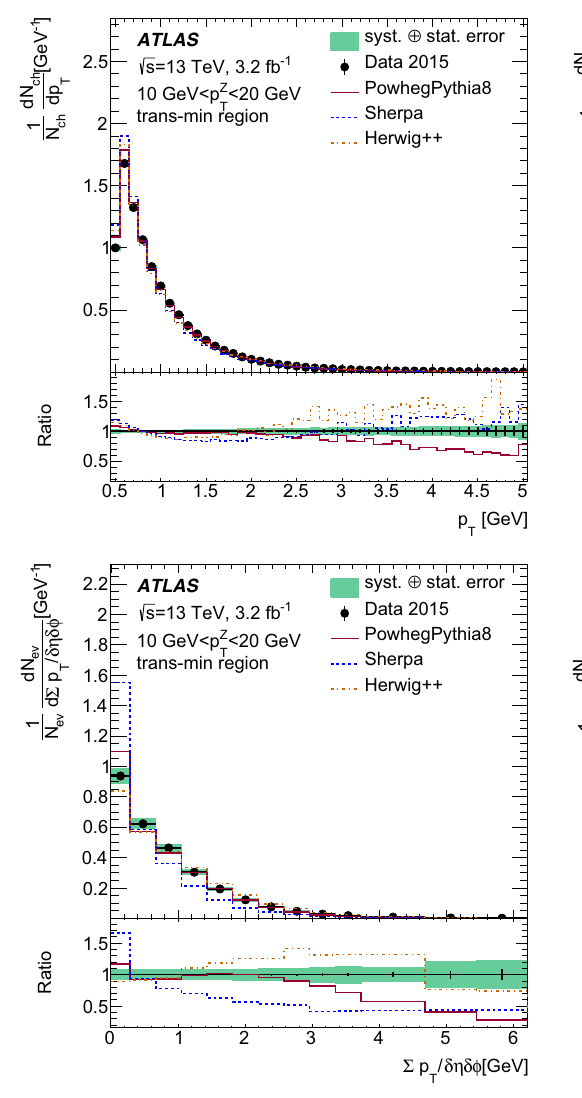
Fig. 4 Measured spectra of p T (upper left), the charged-particle mul- tiplicity, N ch (upper right), the scalar sum of the transverse momentum of those particles, (cid:8) p T , (lower left) and the mean transverse momen- tum, mean p T (lower right) in the trans-min region inclusively in T ⊥